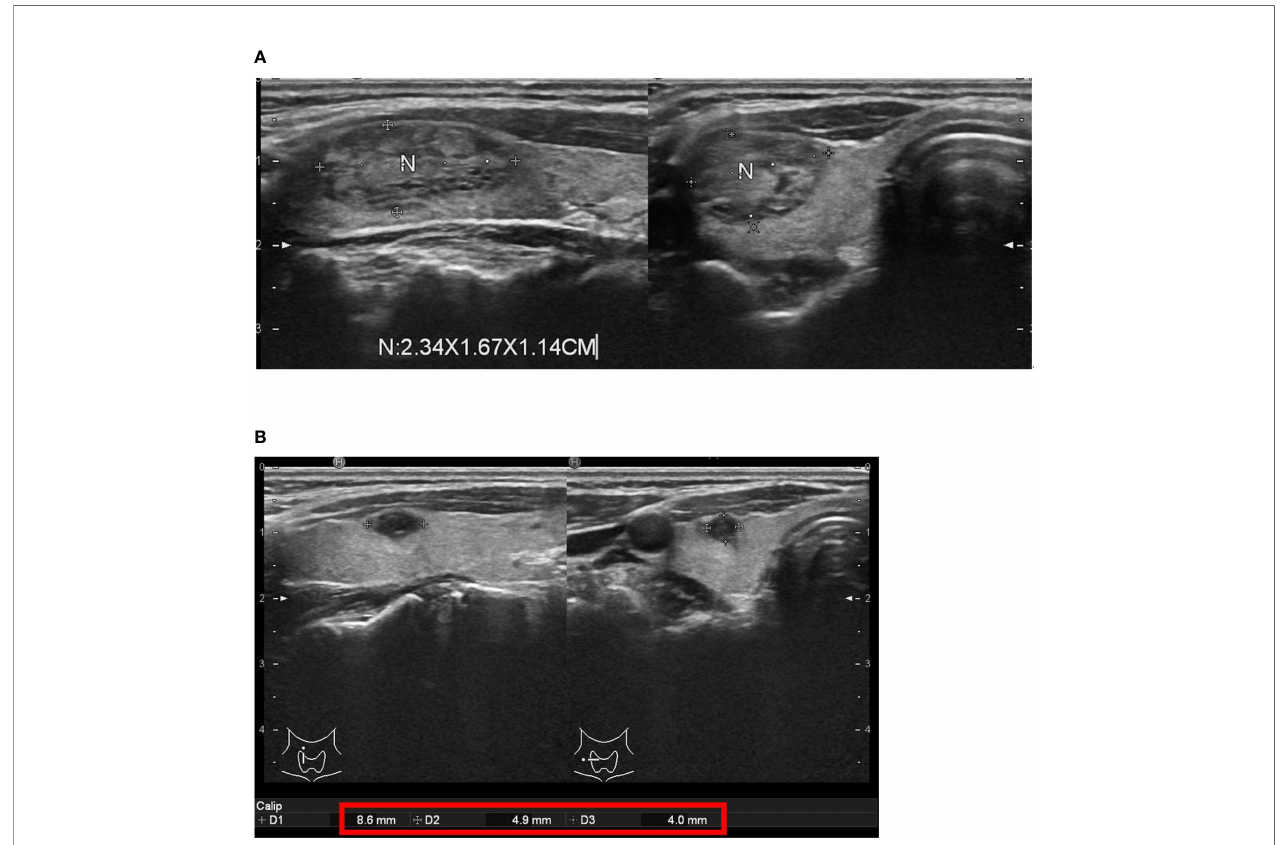
FIGURE 5 | One of our real patients with good response after thyroid radiofrequency ablation (RFA). (A) before thyroid RFA (B) near 97% volume reduction rate 12 months after thyroid